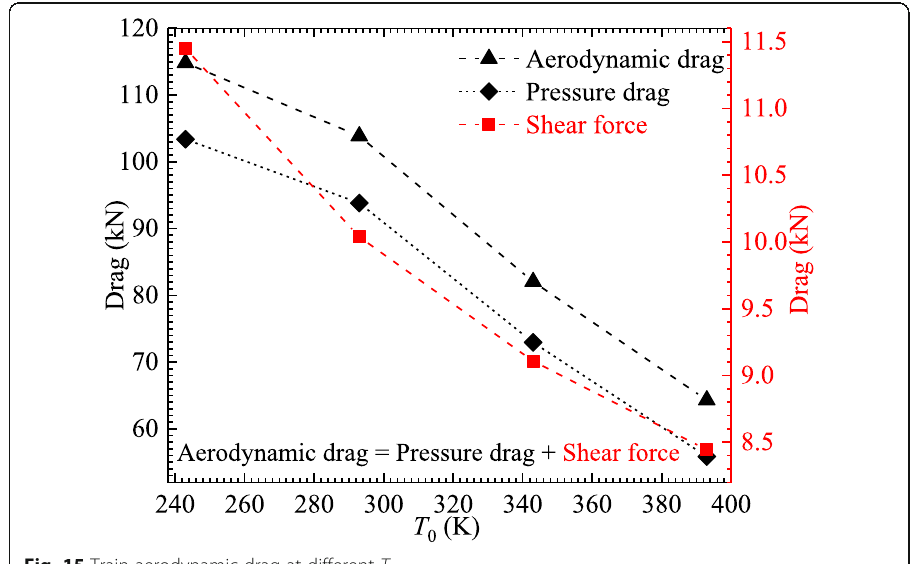
Fig. 15 Train aerodynamic drag at different T